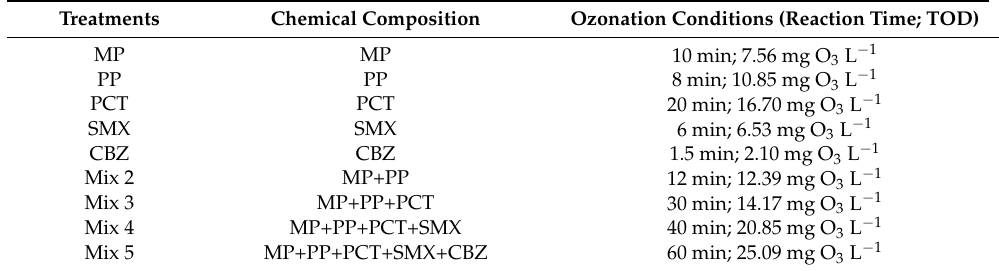
Table 1. The treatments and the ozonation conditions (reaction time and transferred ozone dose— TOD). MP: methylparaben; PP: propylparaben; PCT: paracetamol; SMX: sulfamethoxazole; CBZ: carbamazepine.